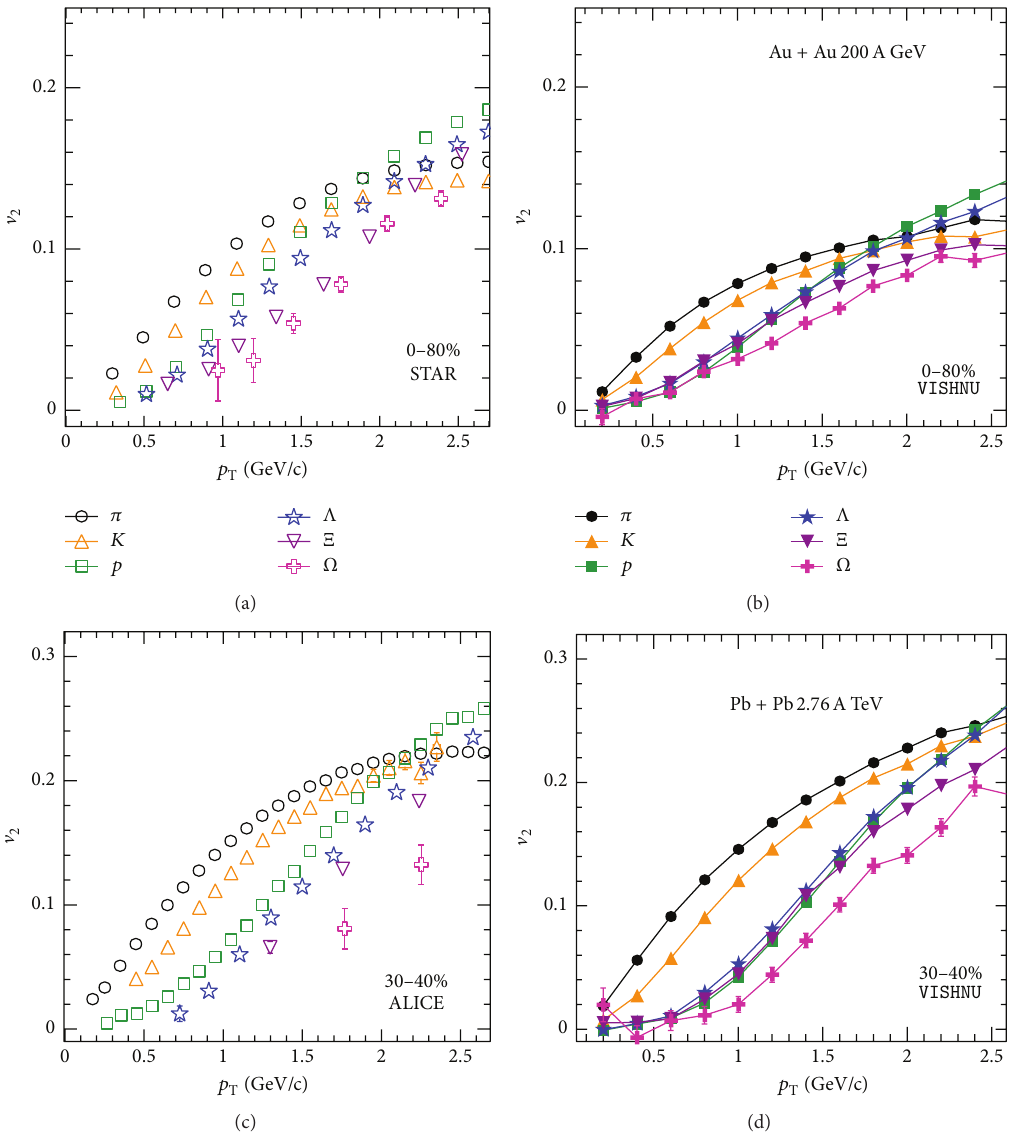
Figure 5: Differential elliptic flow of 𝜋 , 𝐾 , 𝑝 , Λ , Ξ , and Ω at centrality 0–80% in Au + Au collisions at √𝑠 NN = 200 GeV ((a-b), (a) data, (b) VISHNU calculations), and at centrality 30–40% in Pb + Pb collisions at √𝑠 NN = 2.76 TeV ((c-d), (c) data, (d) VISHNU calculations). The measurements of elliptic flow of various hadron species are taken from STAR [15, 20] and ALICE